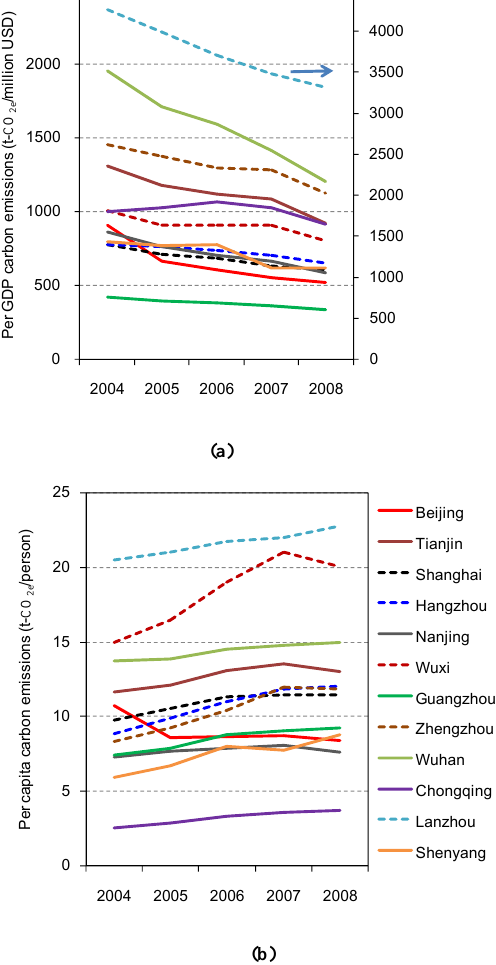
Fig. 3. Carbon emission characteristics of the 12 Chinese cities from 2004 to 2008: (a) per unit of GDP carbon emissions; (b) per capita carbon emissions.